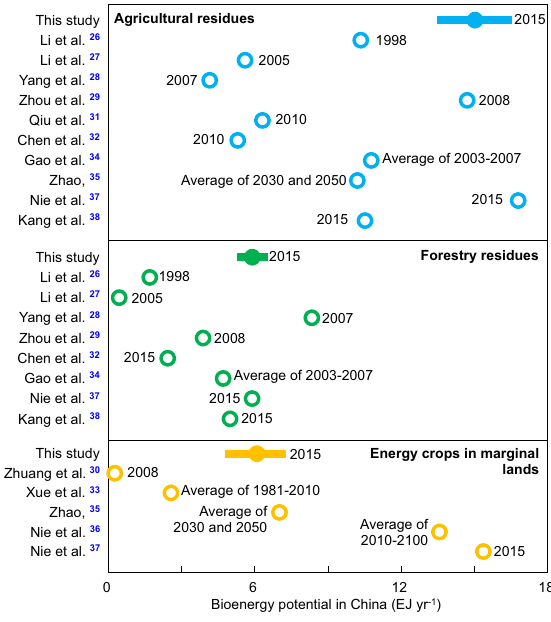
Fig. 1 Comparison of the biomass feedstocks in this study with previous estimates. The bioenergy is converted from the ton of standard coal equivalent (tce) 26,28,32 using a constant ratio of 29.3 GJ tce − 1 (from ref. 26 ) or from the weight of biomass 30 – 33,37 using a constant heat content of 19 GJ (t biomass − 1 ) (from ref. 92 ). Error bars show uncertainties in the estimation from this